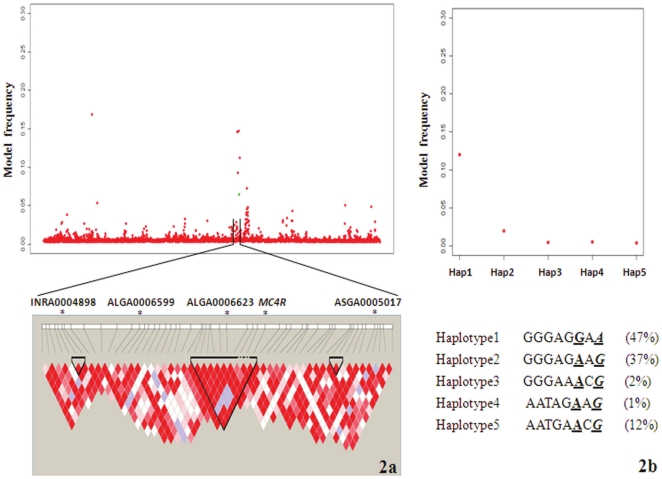
Haplotype analysis.
a) The haplotype blocks of the region between 165.47–168.63 Mb on SSC1 where four SNPs (INRA0004898, ALGA0006599, ALGA0006623 and ASGA0005017) with model frequency greater than 0.10 for 10th rib backfat and the MC4R gene (green color dot) were located , and b) The plots of model frequency for each haplotype containing the SNPs ALGA0006623 (underlined) and MC4R Asp298Asn (Italicized and underlined).